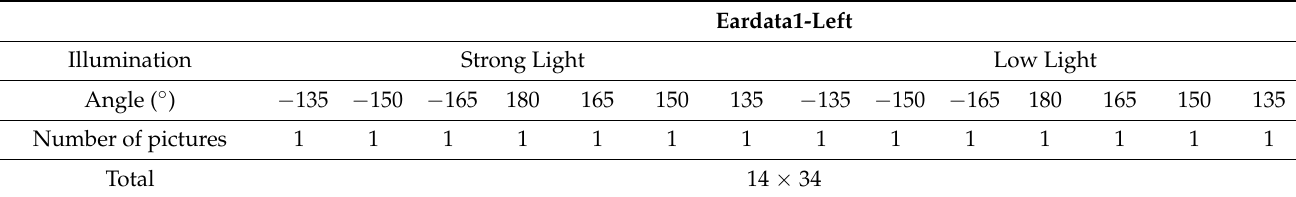
Table 3. Human ear database information of Eardata1-left.